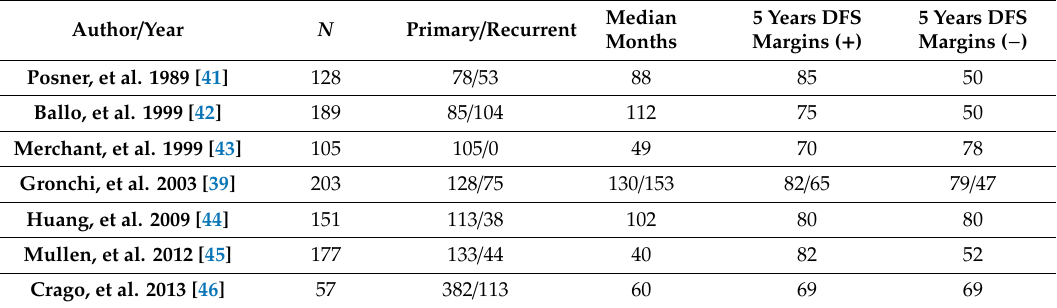
Table 1. Influence of surgical margin on various series